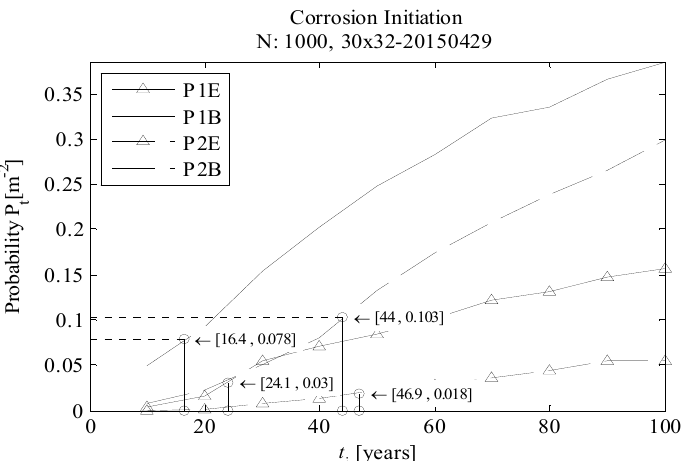
Figure 4: Probability of corrosion initiation t i for the variants considered by type of reinforcement protection. B - unprotected reinforcement, E - epoxy-coated steel reinforcement; and the bridge deck type. 1 - directly exposed bridge deck with a crack, 2 - ordinary concrete and a bridge deck with a crack protected by waterproof insulation under an penetrable asphalt